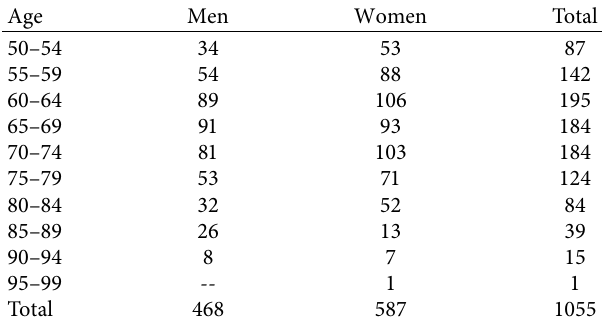
Table 2: Swimmers by age